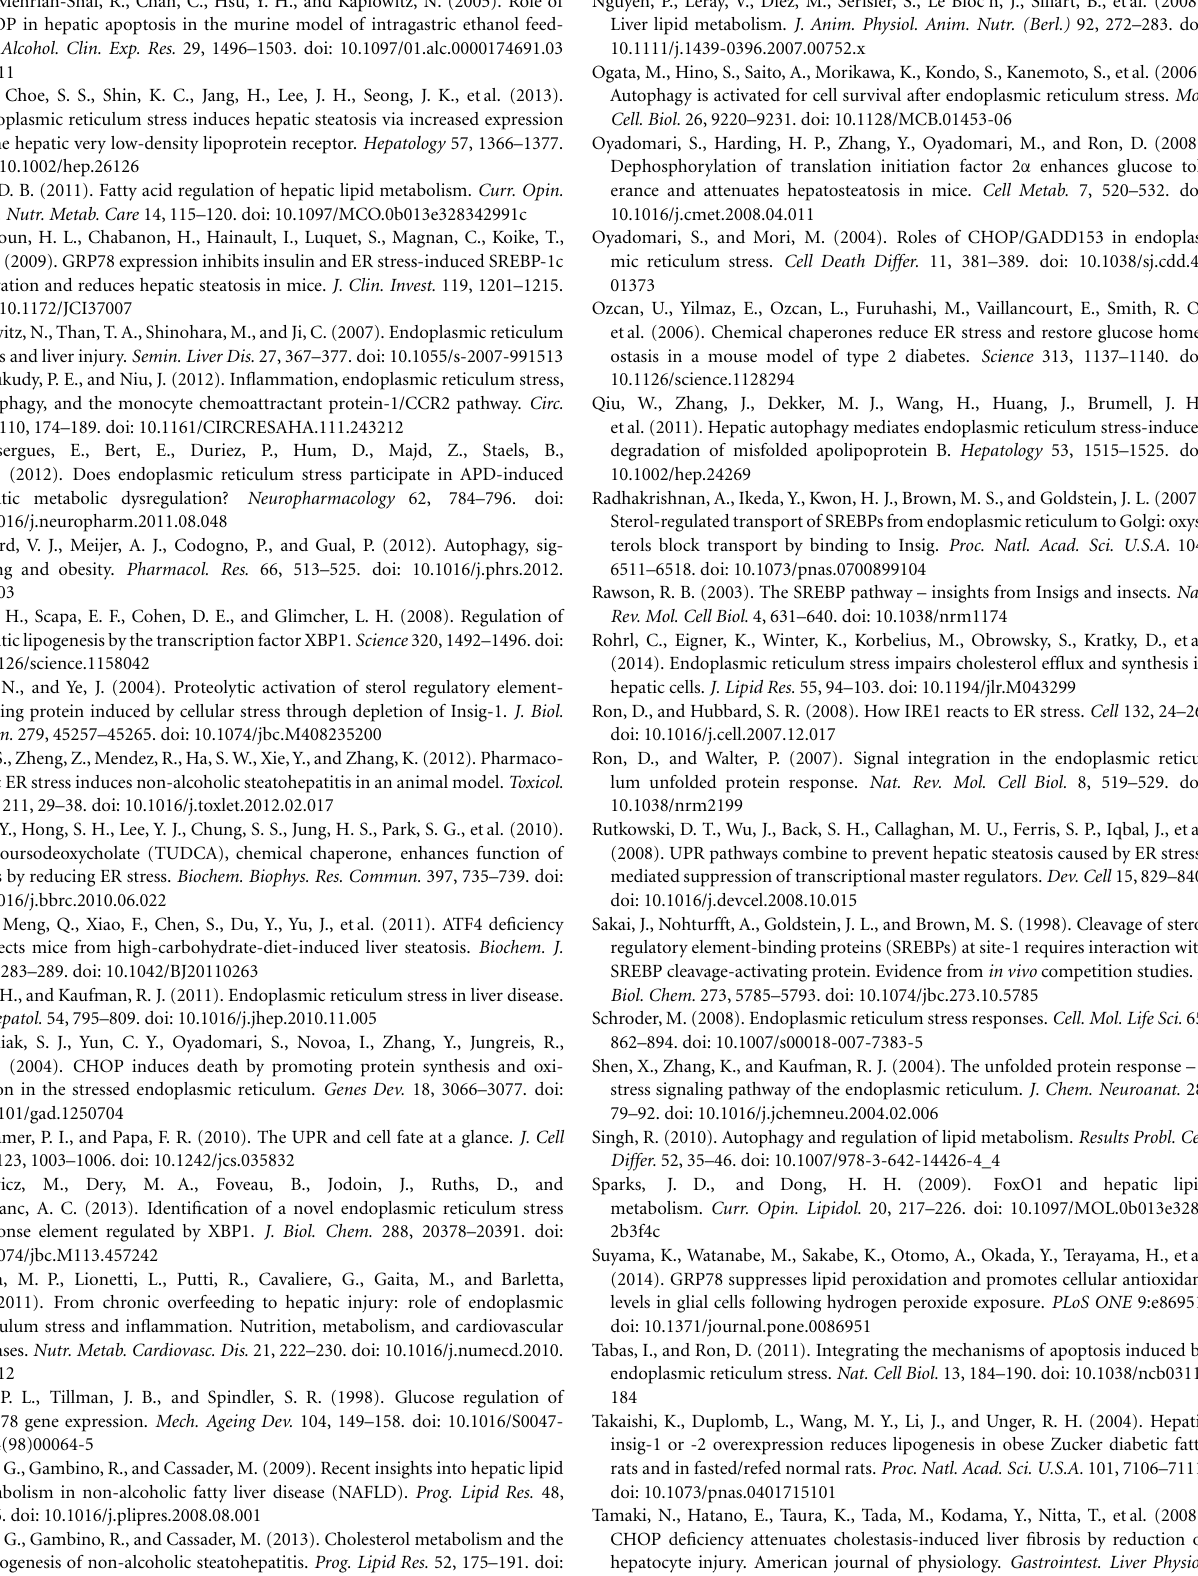
Tabas, I., and Ron, D. (2011). Integrating the mechanisms of apoptosis induced by endoplasmic reticulum stress. Nat. Cell Biol. 13, 184–190. doi: